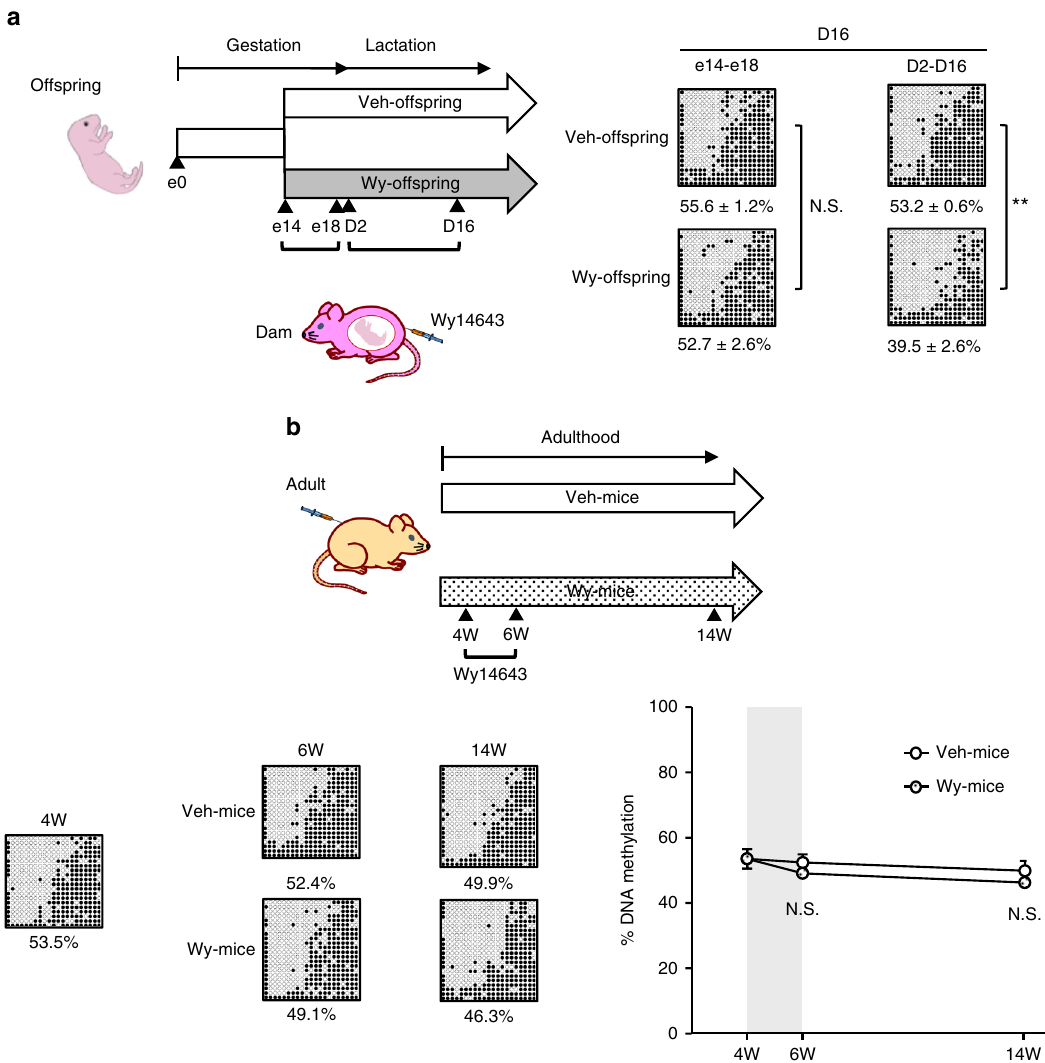
Fig. 3 Life stage-speci fi c DNA demethylation of Fgf21 . a Experimental protocol of maternal administration of Wy or DMSO (Veh) during the late gestation (e14 – e18) and lactation periods (D2 – D16) (left). Bisul fi te-sequencing analysis of the offspring on D16 (right) ( n = 3 – 4 for each group). Statistics by unpaired Student ’ s t -test. Data (% DNA methylation) are expressed as mean ± SEM. ** P < 0.01; N.S.: not signi fi cant vs. Veh-offspring. b Experimental protocol (top) and bisul fi te-sequencing analysis (bottom) in mice treated with Wy or Vehicle from 4W to 6W (Wy- and Veh-mice, respectively). Bisul fi te- sequencing analysis of Fgf21 in Wy- and Veh-mice (bottom left). Representative data of three independent experiments are shown. Graphic presentation of statistical analysis of the bisul fi te-sequencing data (bottom right). The gray-shaded box indicates the period of Wy or Veh administration. ( n = 4 – 5 per group, statistics by one-way ANOVA with Tukey ’ s multiple comparison test). Data are expressed as mean ± SEM. ** P < 0.01; N.S., not signi fi cant vs. Veh-